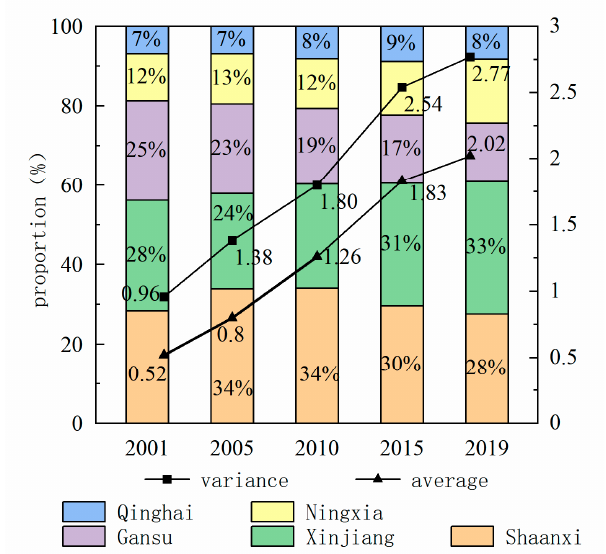
Figure 4. Time-varying trend of CE in northwest China at the county level from 2001 to 2019.